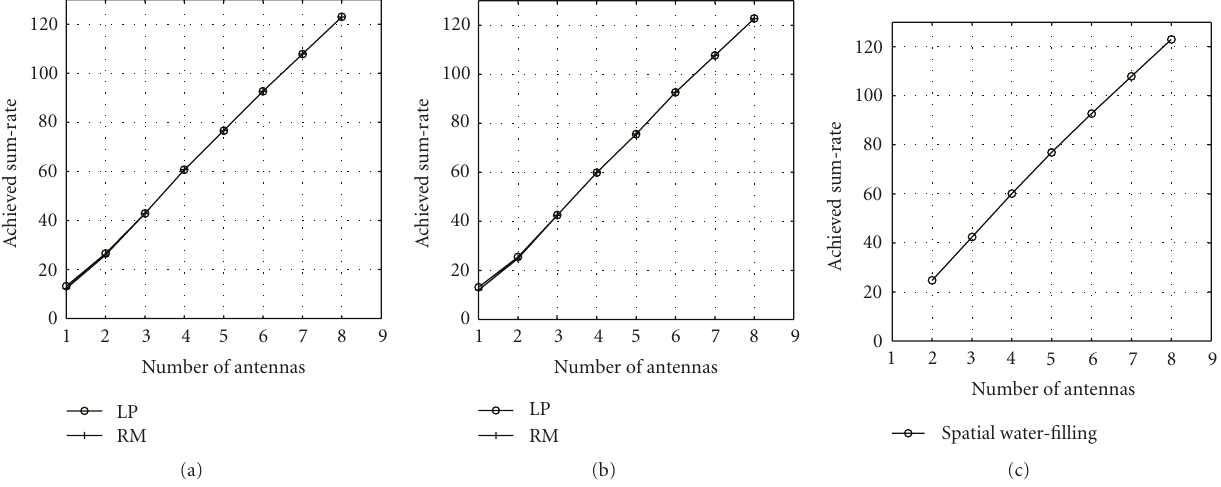
Figure 15: Achieved sum-rate versus the number of antennas for selected scenarios: (a) TSD-MIMO, (b) SVD-MIMO, and (c) spatial waterfilling reference line (LP: Linear Programming, RM: Regret